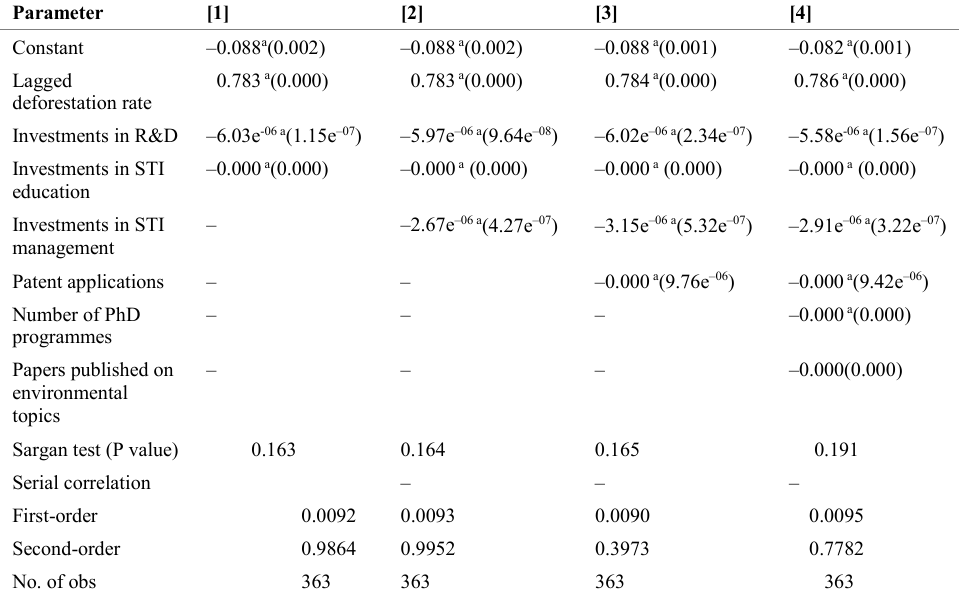
Table 1 and Table 2 show the results of the regression models using a dynamic panel model for green growth measured as the deforestation rate by department for the science and technology model (Eq. 4 and Table 2) and the environmental and energy model (Eq. 5 and Table 3), determining the key variables in the relationship of STI and green growth, as explained in this section. The tests applied in both models indicate that the results are robust because the Sargan test of overidentifying restrictions does not reject the null hypothesis that the instruments are not correlated with the error process. In both models, the results for the lagged deforestation rate show a positive and significant effect on deforestation rates, thus indicating that deforestation can be explained over time by different